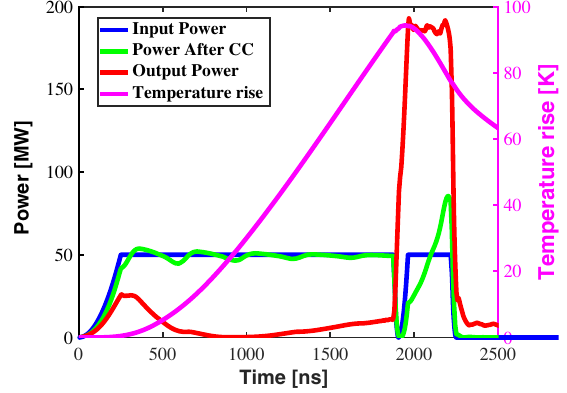
FIG. 17. Electrical field distribution of the storage cavity with the E-rotator. The electrical field is in logarithmic